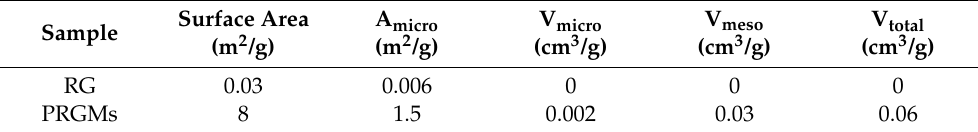
Figure 1. SEM images of ( a ) as received RG (particle size ≤ 63 µ m), ( b , c ) surface morphology of porous recycled glass microspheres (PRGMs) at different magnification, ( d , e ) cross-section of PRGMs at different magnification and ( f ) XRD pattern of RG and PRGMs. Table 1. A pore size and pore volume analysis using t-plot and BJH method by nitrogen adsorption desorption analysis.